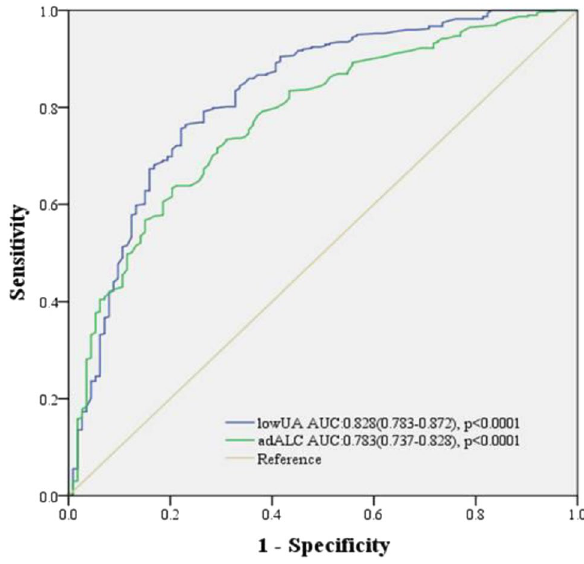
Figure 3. ROC curves showed the prognostic value of low UA and ad ALC in predicting in-hospital